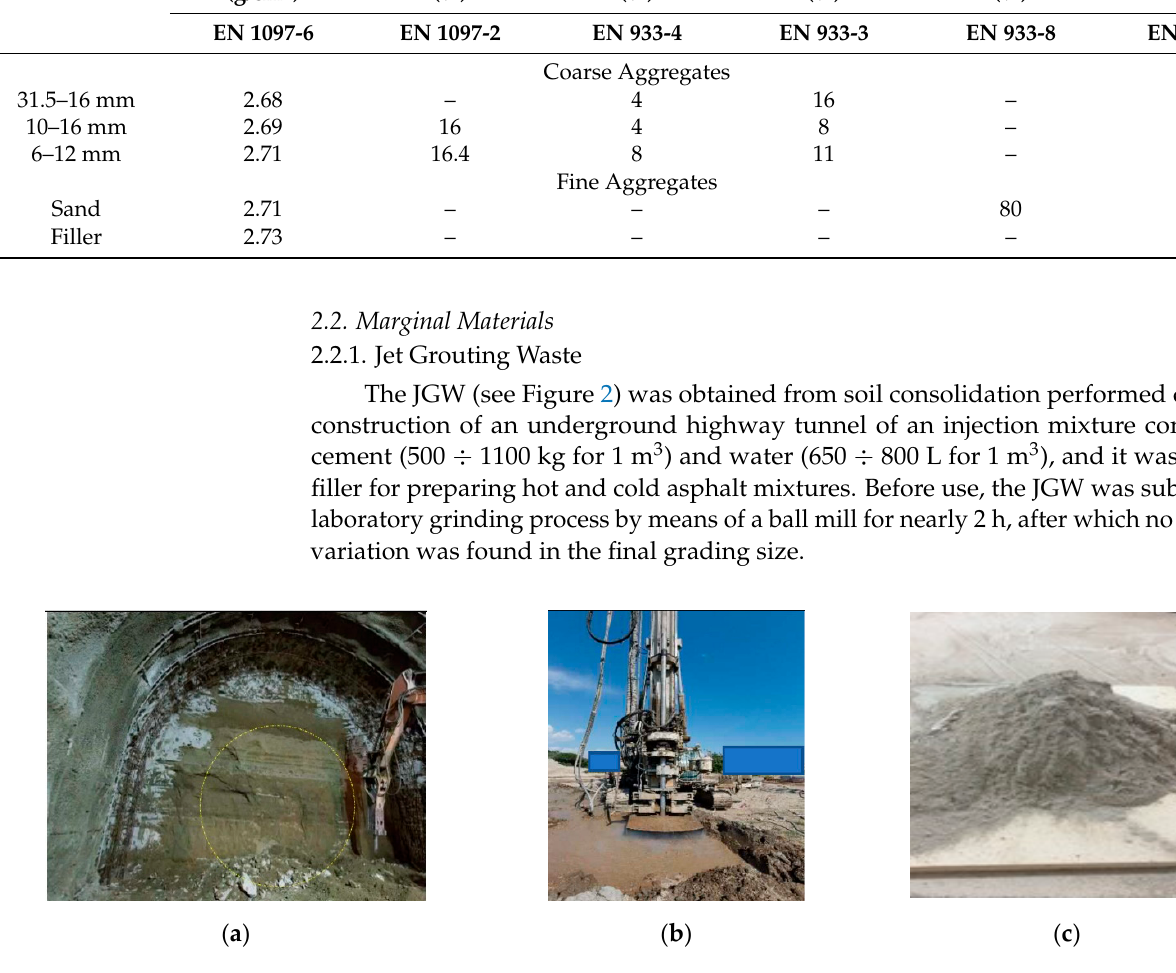
Figure 2. Jet grouting waste: ( a ) jet grouting columns, ( b ) JGW drawn to the surface; ( c ) JGW after grinding action.